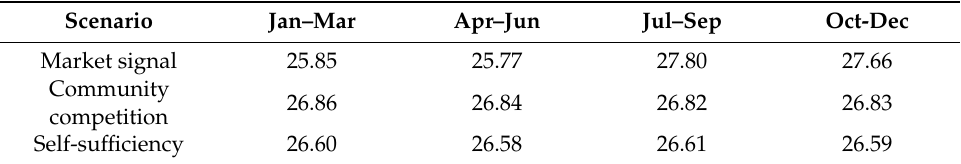
Table A2. Mean values of electricity tariffs during different seasons.